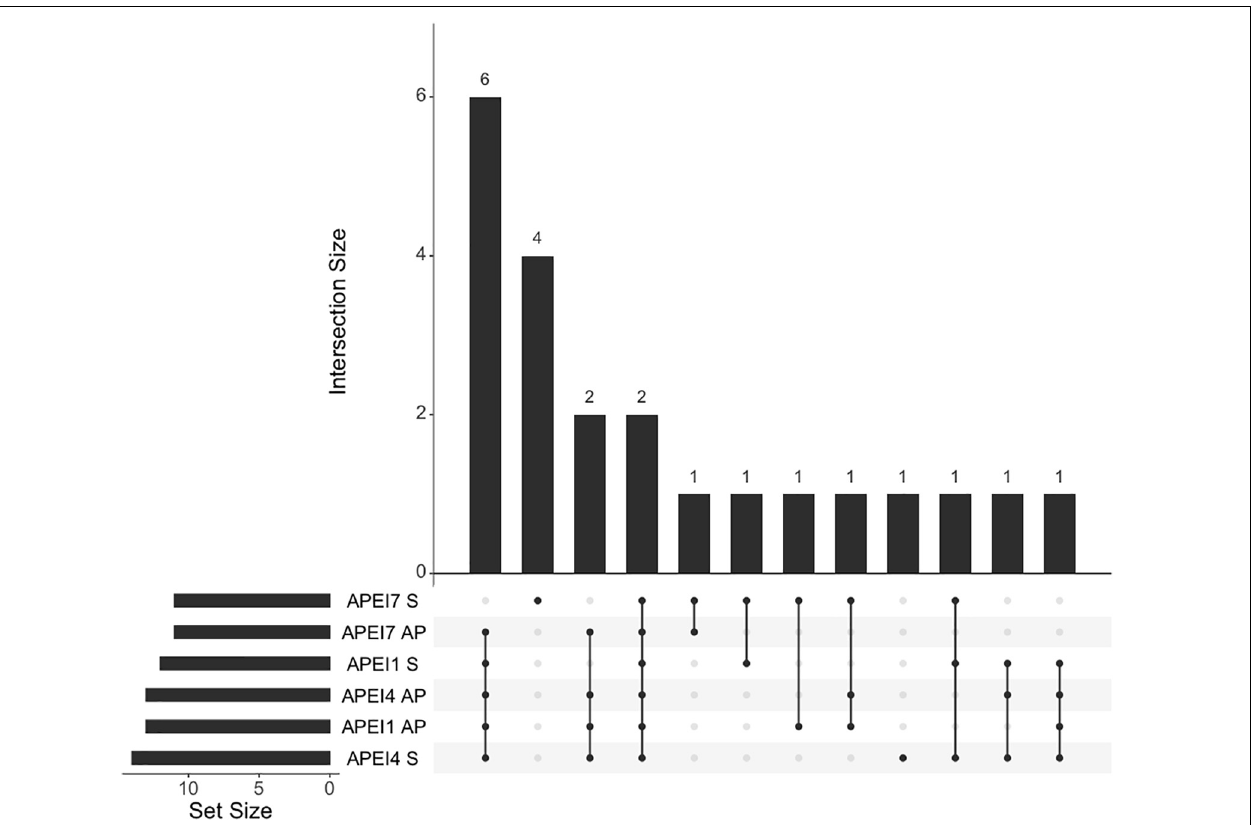
FIGURE 6 | Intersection sizes in community composition between sampling station. Numbers of samples at each station are displayed on the bottom left bar chart. Vertical bars show intersection sizes between stations marked with dots listed along the x axis. Chart produced with {UpSetR} (Gehlenborg,